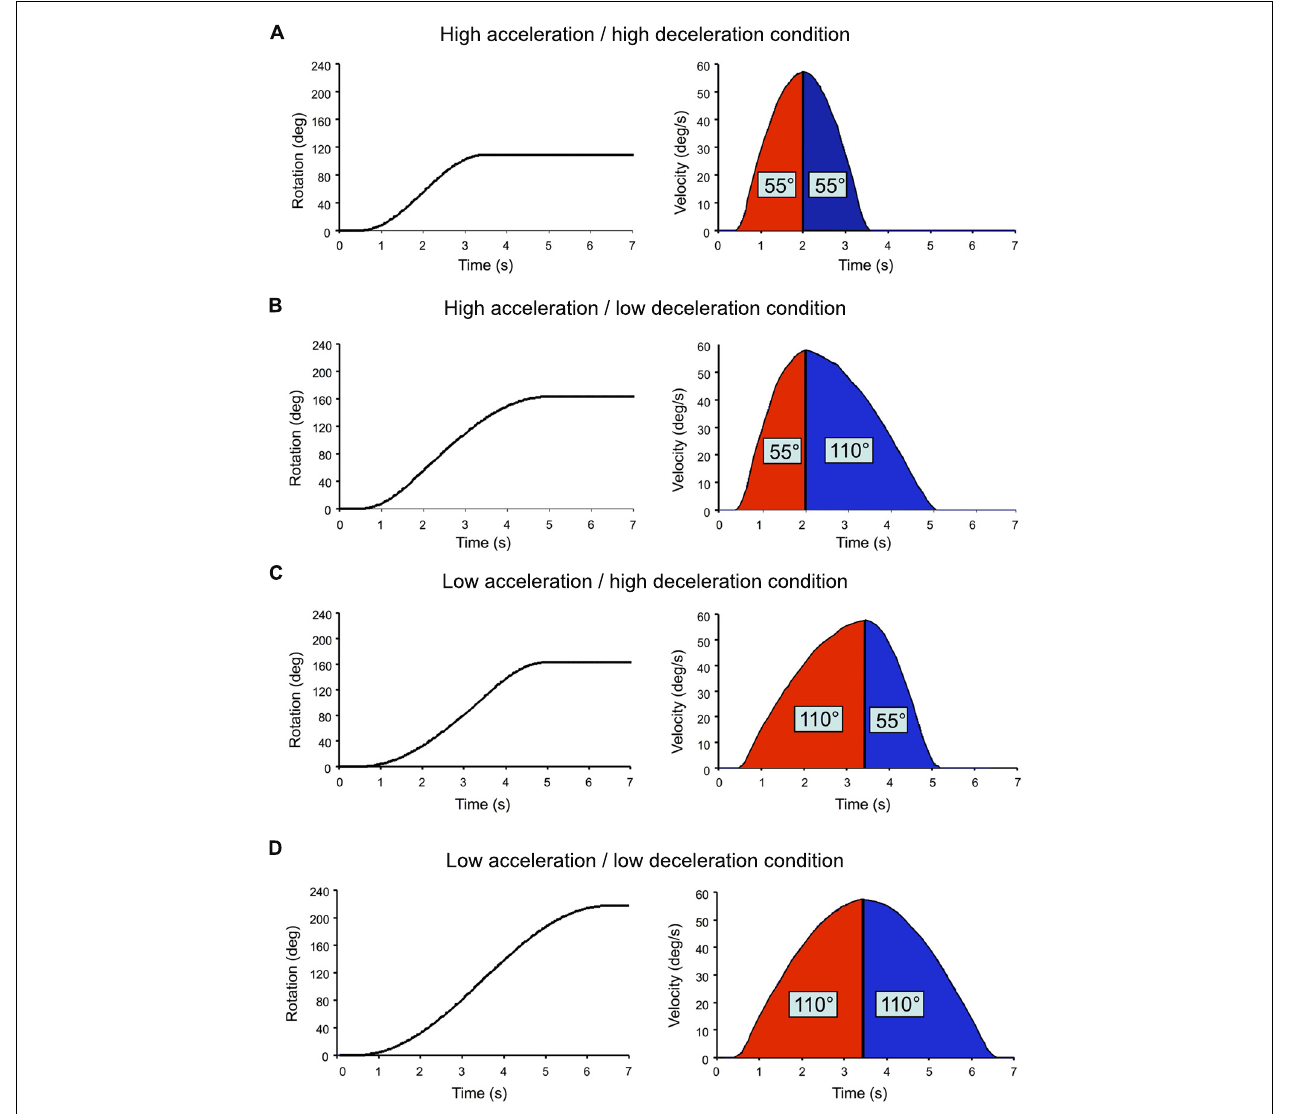
recordings. (A) High acceleration/high deceleration condition; (B ) high acceleration/low deceleration condition; (C) low acceleration/high deceleration condition; (D) low acceleration/low deceleration